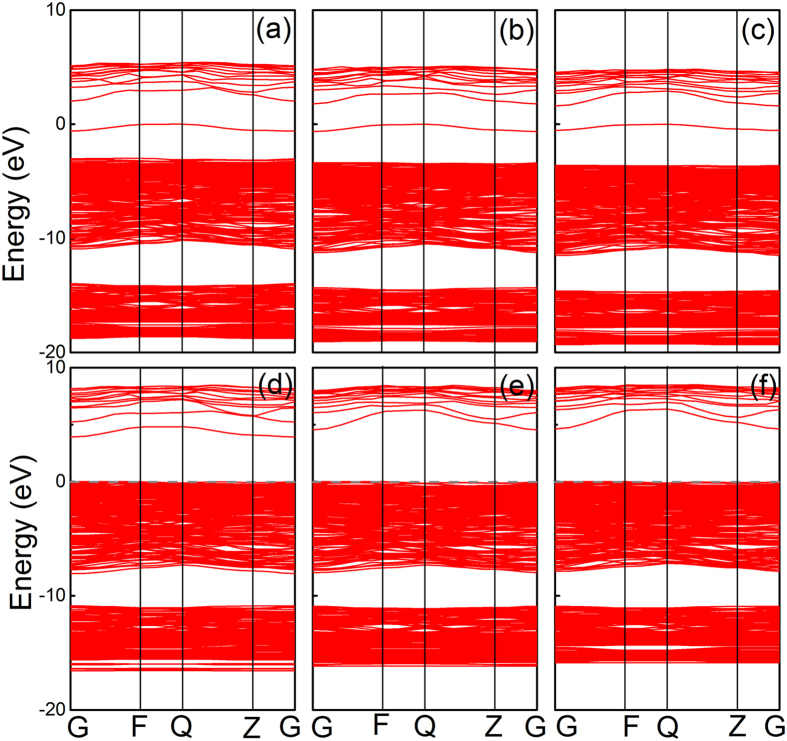
Band structures of β-Ga2O3 with oxygen vacancies in (a) , (b) , (c) , (d) , (e) , and (f)  states.